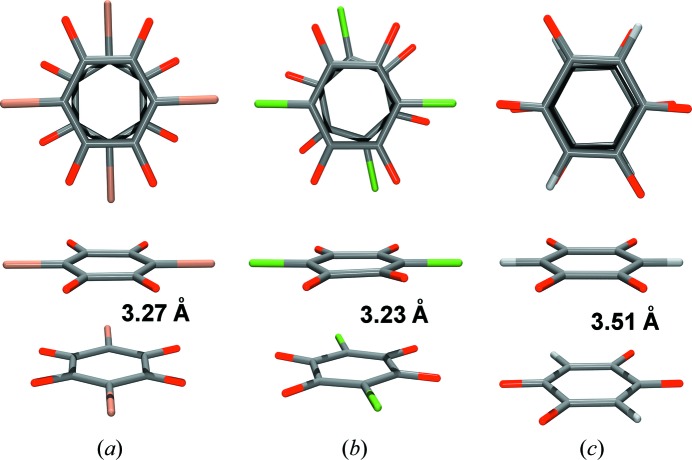
Pairs of contiguous quinoid rings in face-to-face stacks. (a) Hydrogen bromanilate monoanions (Molčanov & Kojić-Prodić, 2012 ▸) in a staggered arrangement. (b) Hydrogen chloranilate monoanions (Molčanov et al., 2009b
 ▸) in a partially staggered arrangement. (c) DHQ2− dianions in an eclipsed arrangement (Molčanov et al., 2013b
 ▸). Figure adapted from Molčanov et al. (2013b
 ▸).